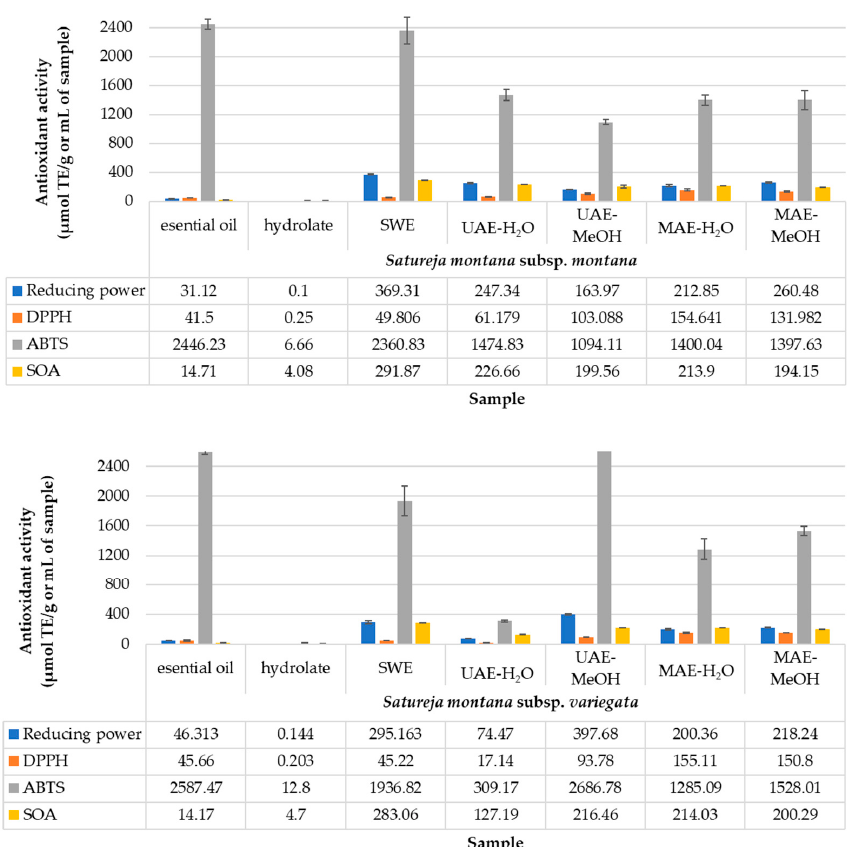
Figure 2. Antioxidant